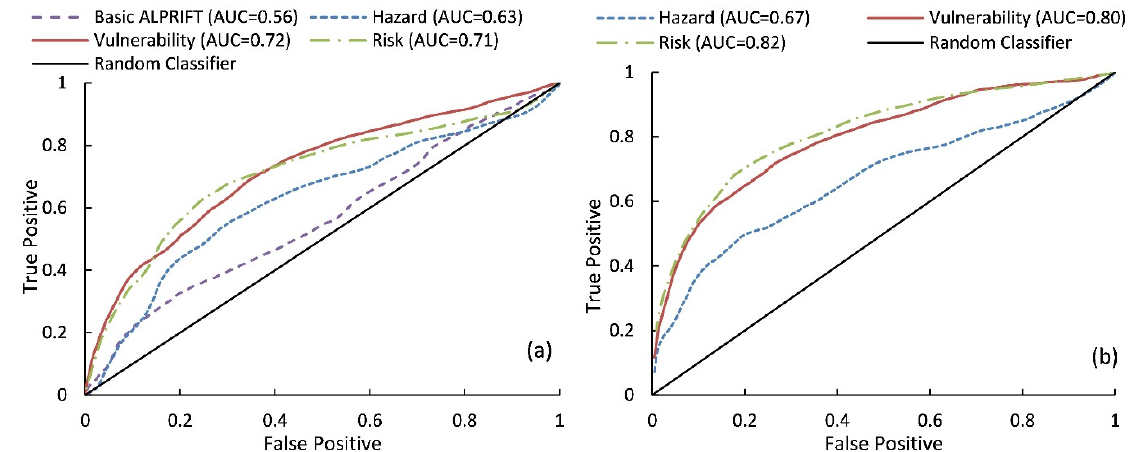
Figure 6. Performance evaluation by ROC/AUC: ( a ) results at Level 1; ( b ) results at Level 2.